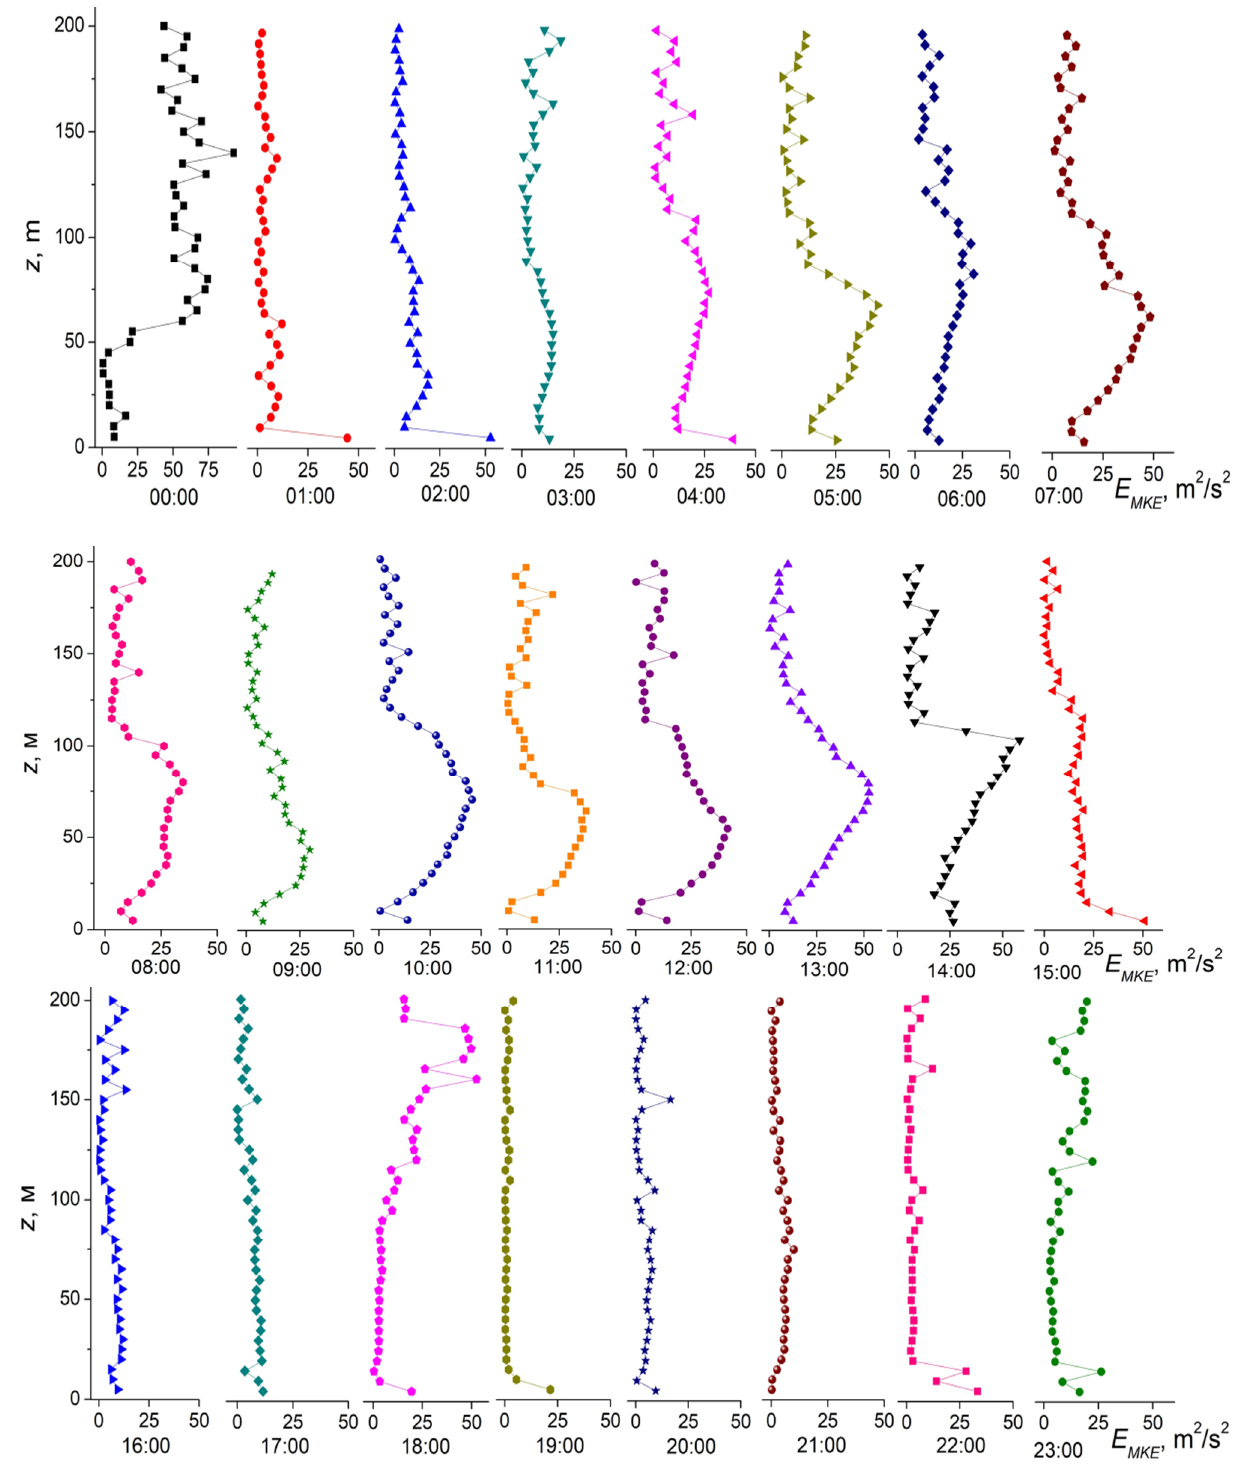
Figure 2. Diurnal hourly dynamics of the mean kinetic energy retrieved from minisodar measurements with 10-min averaging. The start time of the 10-min measurement series is indicated in the lower right corner of the plots.